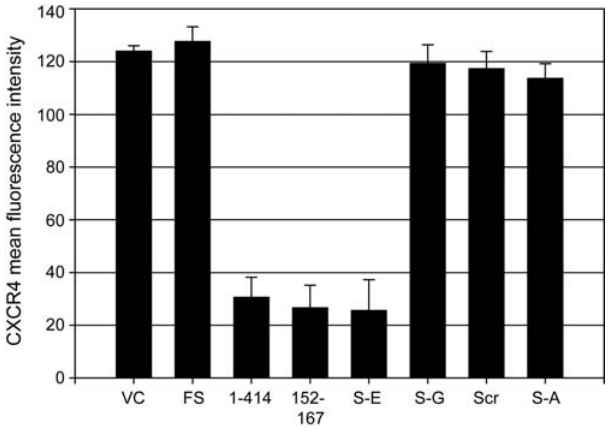
Figure 6. GBV-C NS5A peptides downregulate CXCR4 expres- sion. Cells expressing the full-length NS5A (1–414), the 152–167 and S158E peptide had significantly less CXCR4 on their surface than did cells containing the vector control (VC), frameshift (FS), scrambled 152– 167 peptide sequence (Scr), or the S158G, and S158A peptides. Data represent the mean fluorescent intensity of CXCR4 on the surface of these cells measured by flow cytometry.